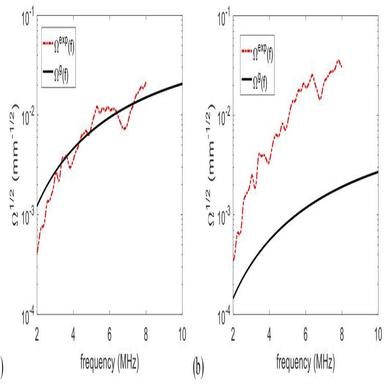
Experimental and theoretical amplitude of backscattering coefficients in different samples. (a) Wrought aluminum alloy, and (b) WAAM aluminum alloy.